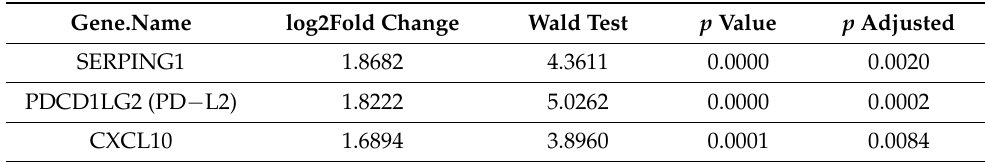
Table 2. Differential gene expression analysis